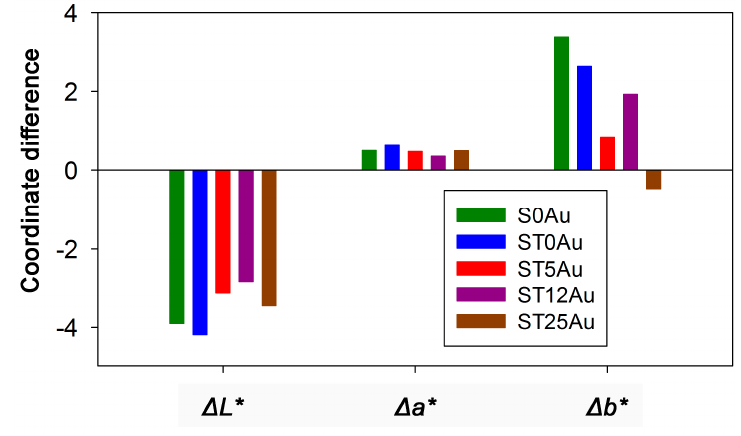
Figure 7. Changes in colour coordinates induced by the products under study.